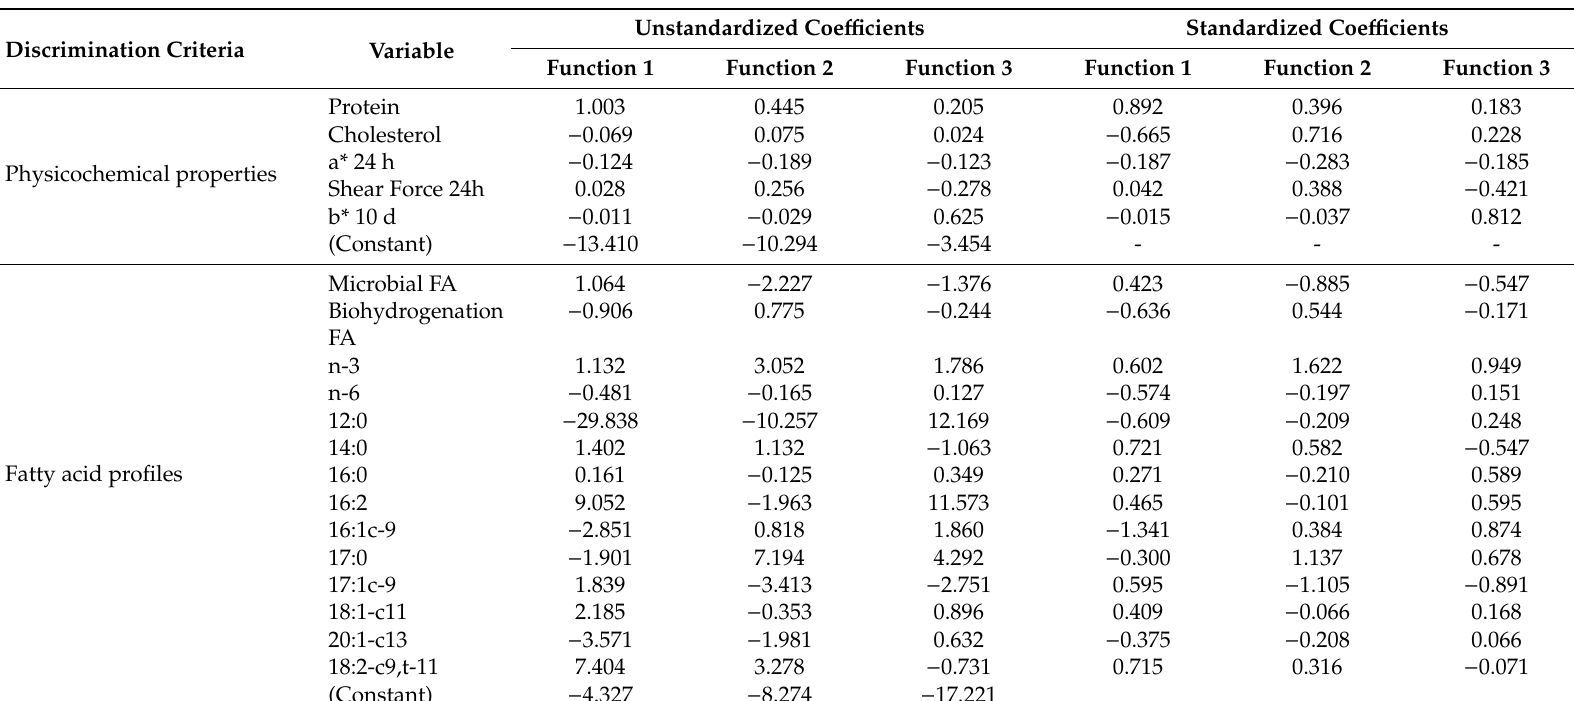
Table 5. Estimated coe ffi cients of the canonical discriminant function on the predictor variables, in discriminant analyses of genetic groups × finishing system combinations based on meat physicochemical properties, fatty acid profiles or